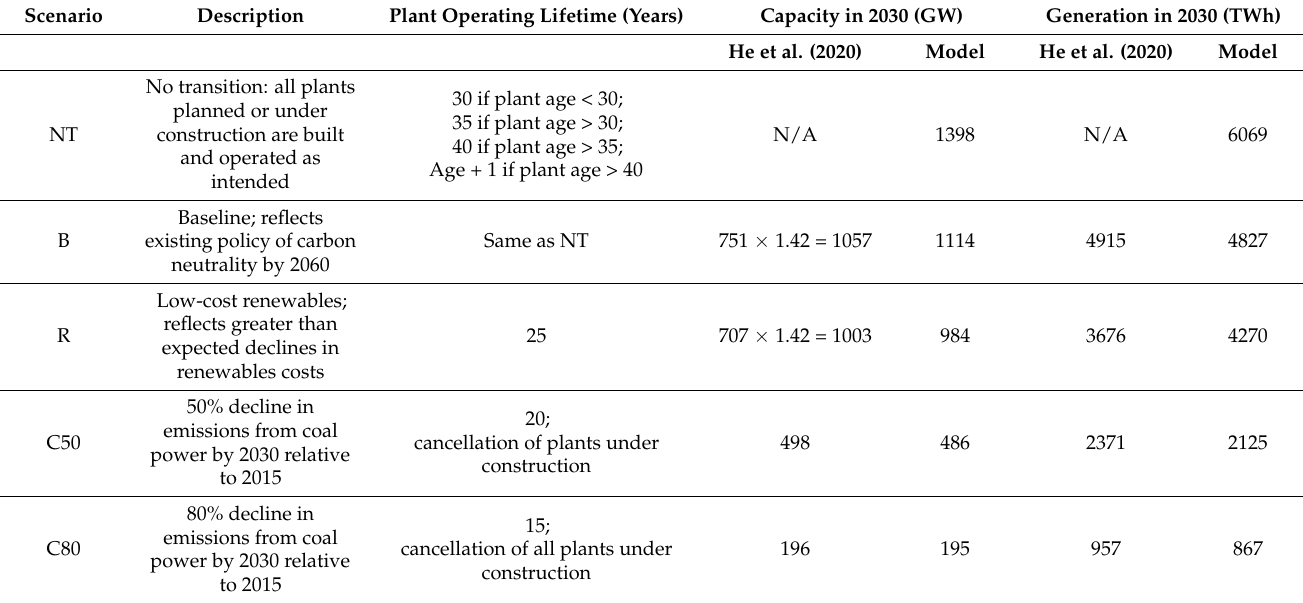
Table A2. Overview of coal phase-out scenarios employed.